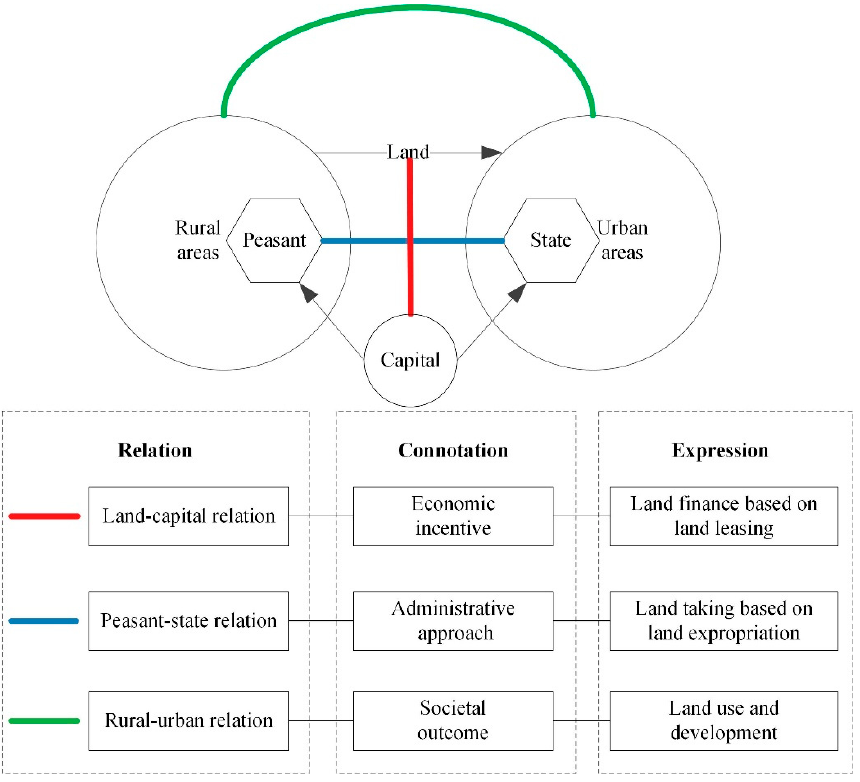
Figure 6. The interaction of three relations.